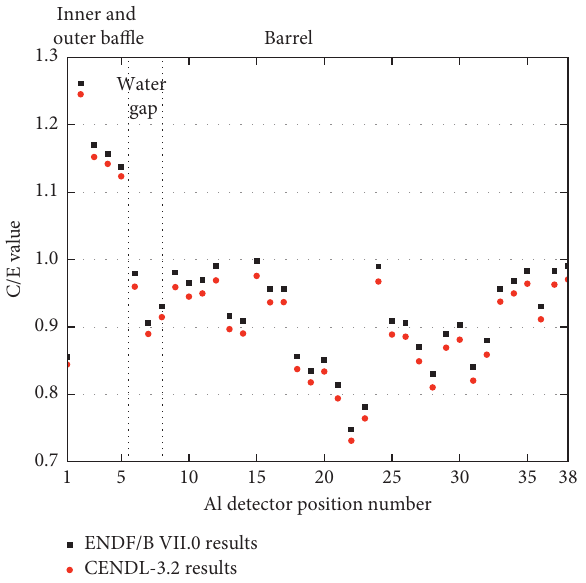
Figure 7: Equivalent fission flux ratios (calculated/experimental) of the 27 Al(n, α ) 24 Na detector.